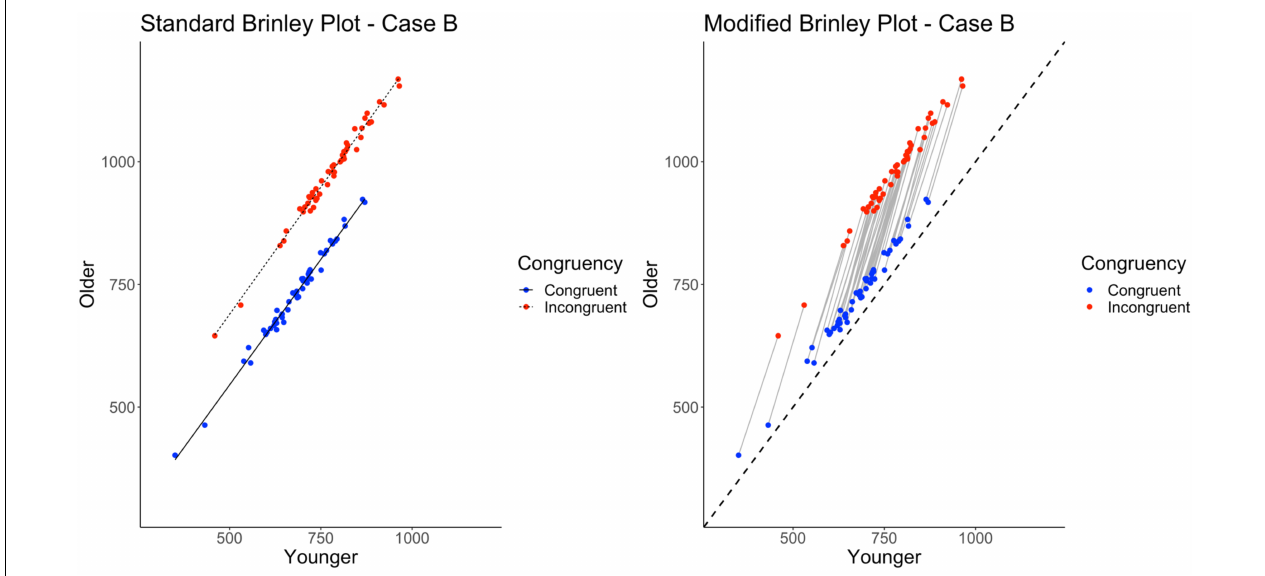
FIGURE 4 | Standard and modified Brinley plots—Case B data. Standard and modified Brinley plots (left and right, respectively) for the Case B simulated data which was simulated such that the magnitude of the interaction was increased. Means (SD) used for Case B were as follows: Young Congruent = 700 (150), Young